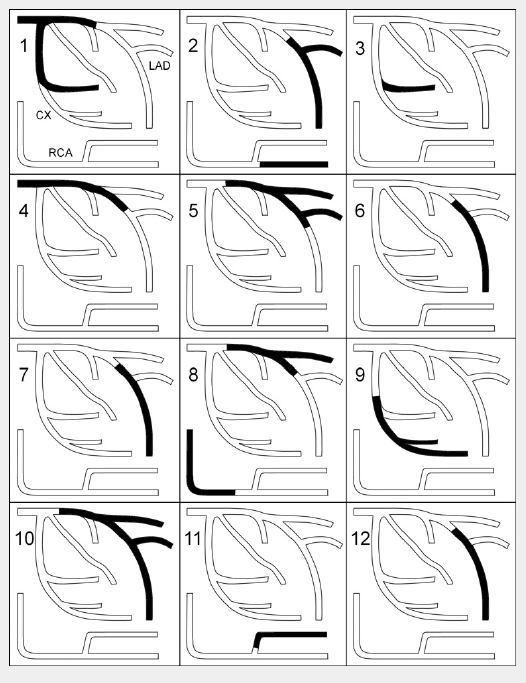
Segmental distribution of coronary artery dissections in patients with (1–3) and without (4–12) renal artery